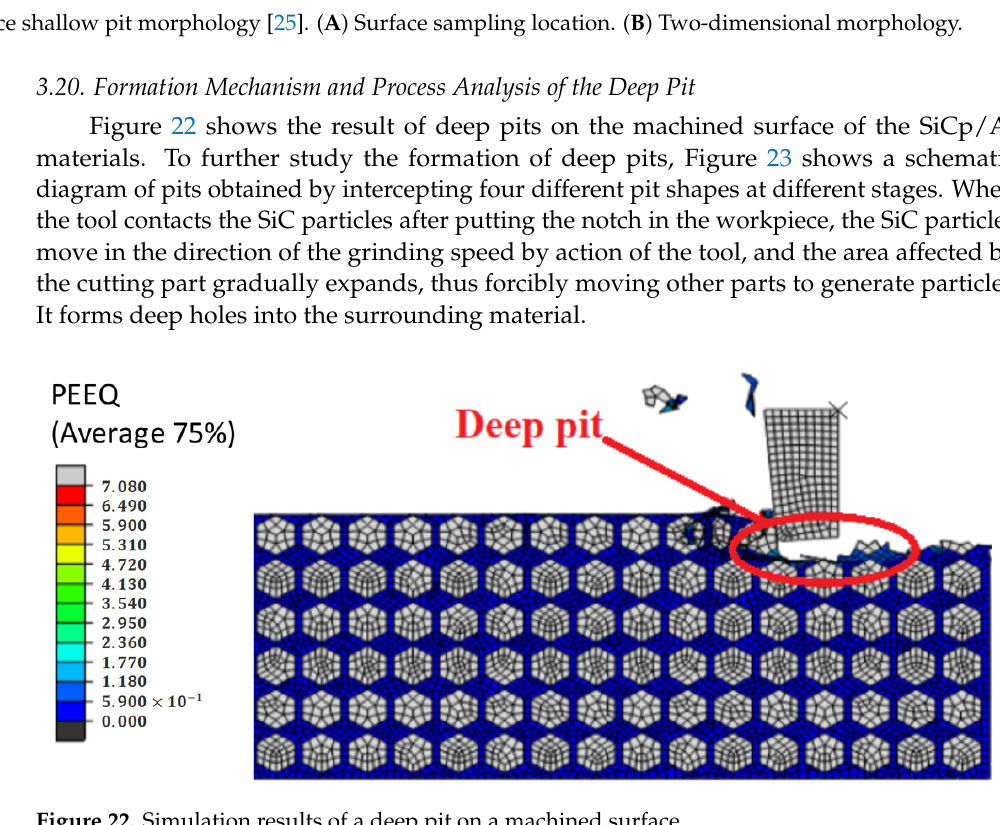
Figure 21. Typical surface shallow pit morphology [25]. ( A ) Surface sampling location. ( B ) Two-dimensional morphology.